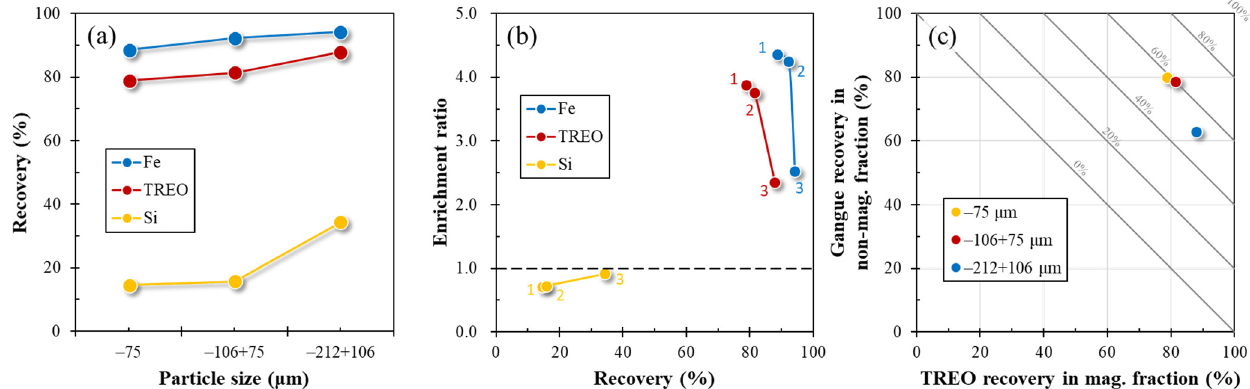
Figure 8. Effect of particle size on ( a ) the recovery of TREO, Fe, and Si from REE ore, ( b ) enrichment ratio as a function of recovery, and ( c ) relationship between TREO recovery in magnetic fraction and gangue recovery in non-magnetic fraction. Note: The numbers in Figure 8b denote that particle size (1: − 75 µ m, 2: − 106 + 75 µ m, 3: − 212 + 106 µ